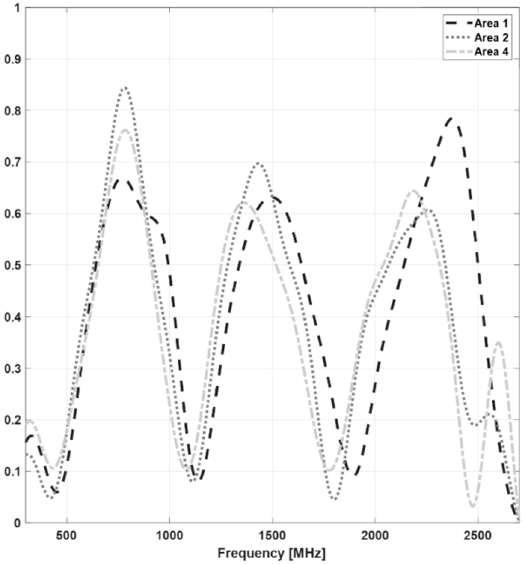
Figure 17. Amplitude variations versus frequency for the areas with the delineated structure.